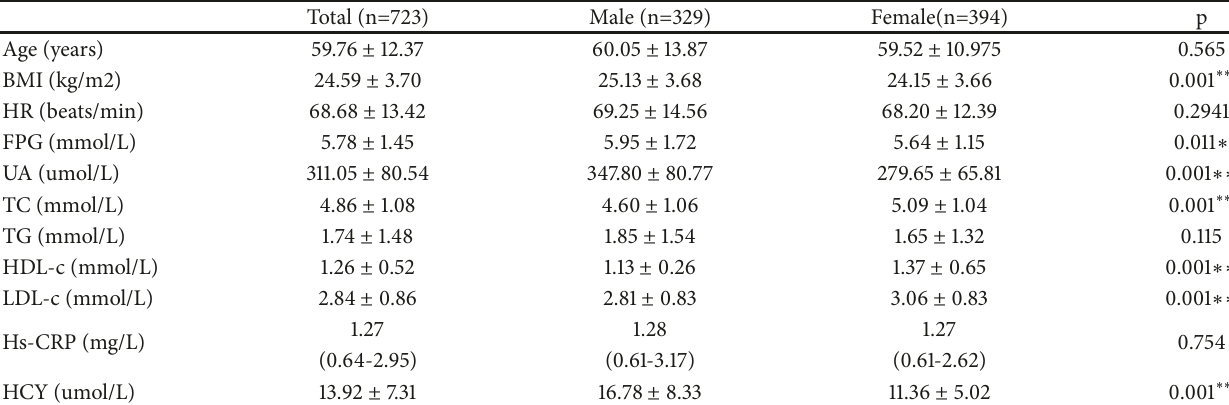
Table 1: Clinical features of subjects in general, male and female population.